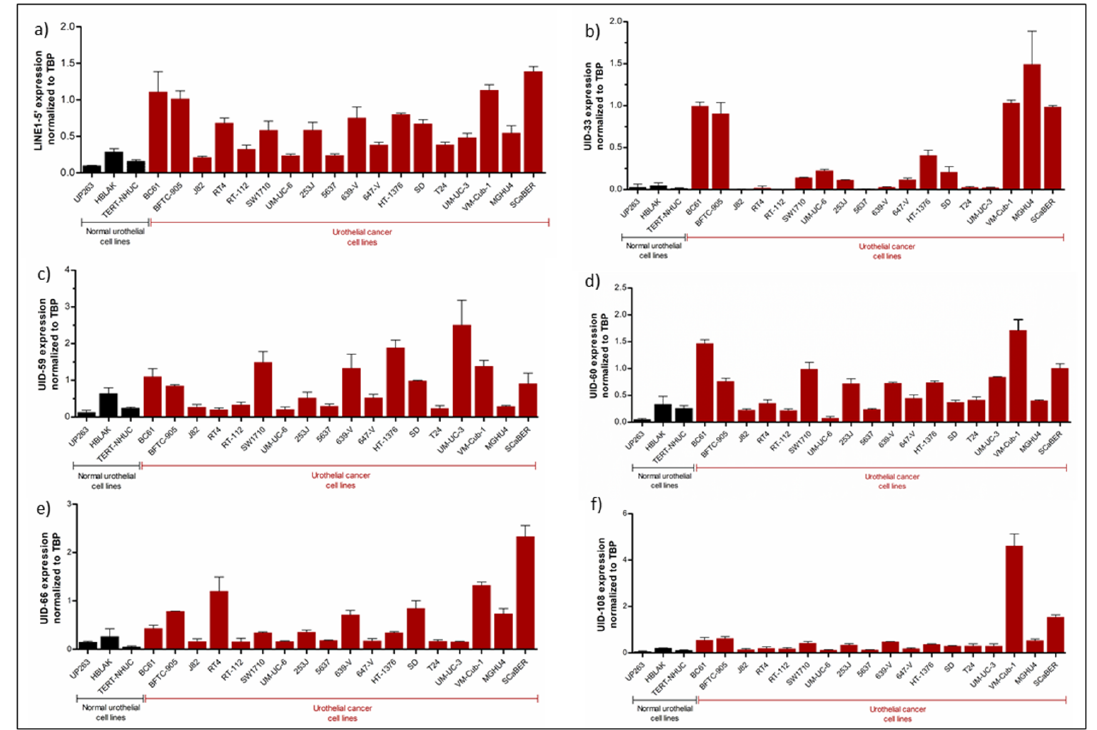
Figure 2. L1 expression across bladder cancer cells and normal urothelial cells. Measurements of RNA expression of overall LINE-1 (flL1) using the 5’-LINE1 assay ( a ) and the individual elements UID-33 ( b ), UID-59 ( c ), UID-60 ( d ), UID-66 ( e ) and UID-108 ( f ) were performed by quantitative real-time PCR. TBP was used as a reference gene.